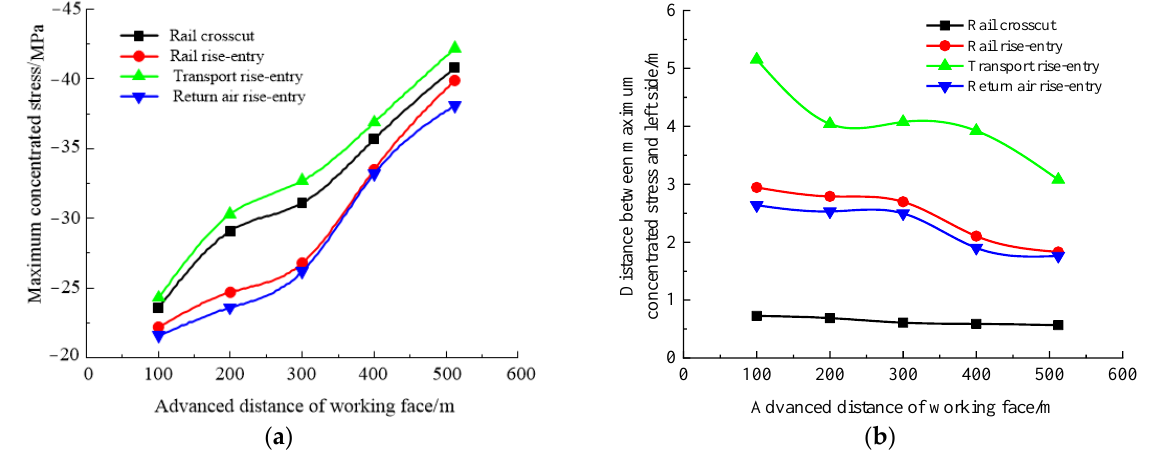
Figure 7. Maximum concentrated stress and its position monitoring results in the advancing process of the No. 360801 coal face. ( a ) Maximum concentrated stress, ( b ) Position of maximum concentrated stress.